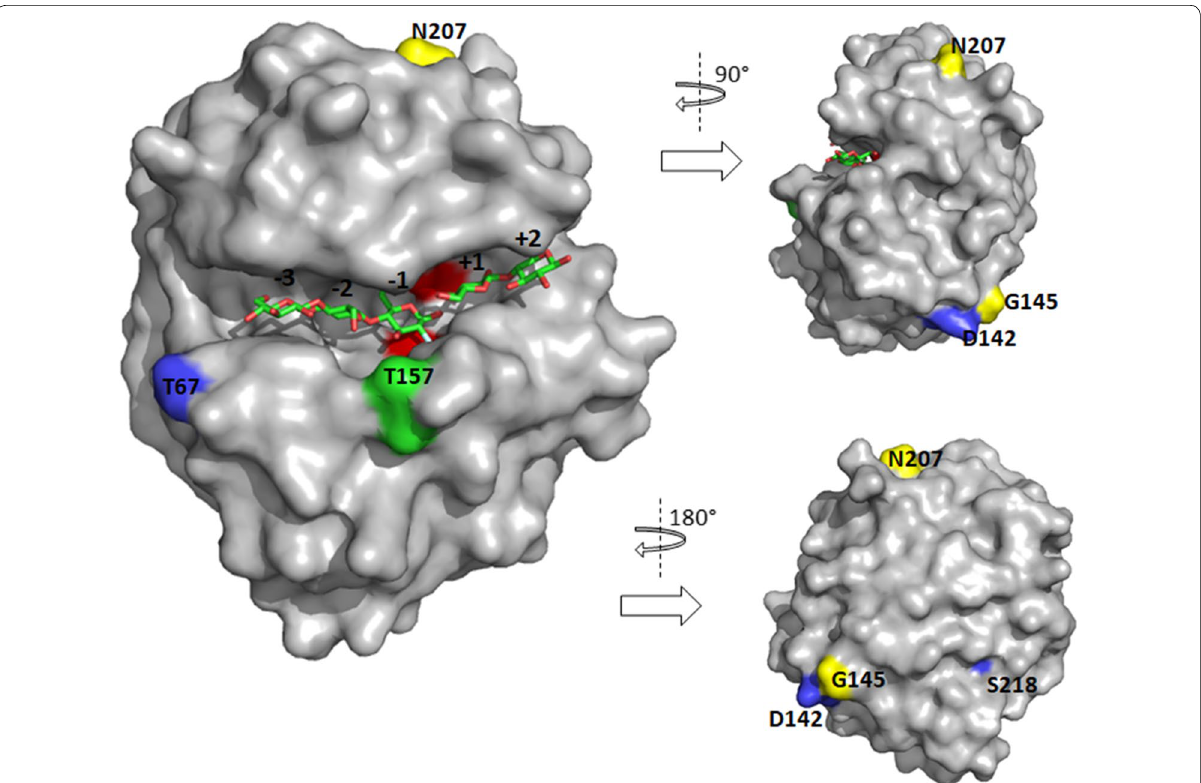
Fig. 2 Homology model of the catalytic module of CelStrep. Surface view of the catalytic cleft of CelStrep with cellotriose modelled in the and 3 subsites and cellobiose modelled in the − substituted labelled amino-acids are coloured according to the epCelStrep variant: epCS_2 (yellow), epCS_4 (blue), epCS_5 (green)